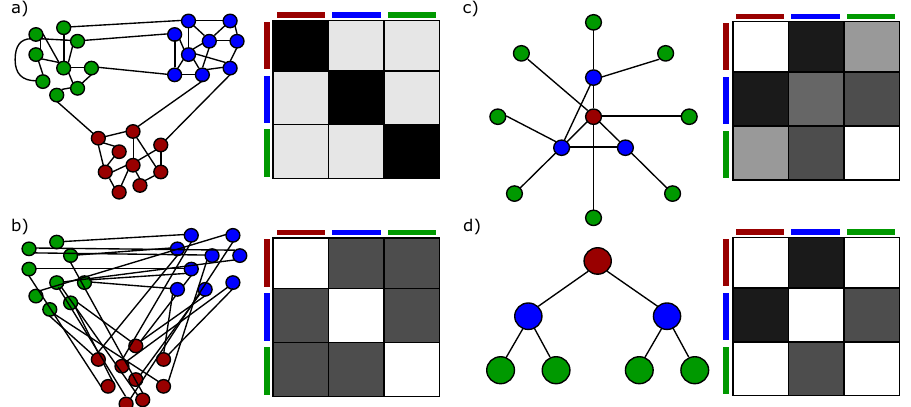
Fig 1. General structures and their representation as a standard SBM. The standard SBM is represented as a block matrix with the probabilities visualized in a grey-scale. a) assortative structure b) disassortative structure c) core- periphery d)